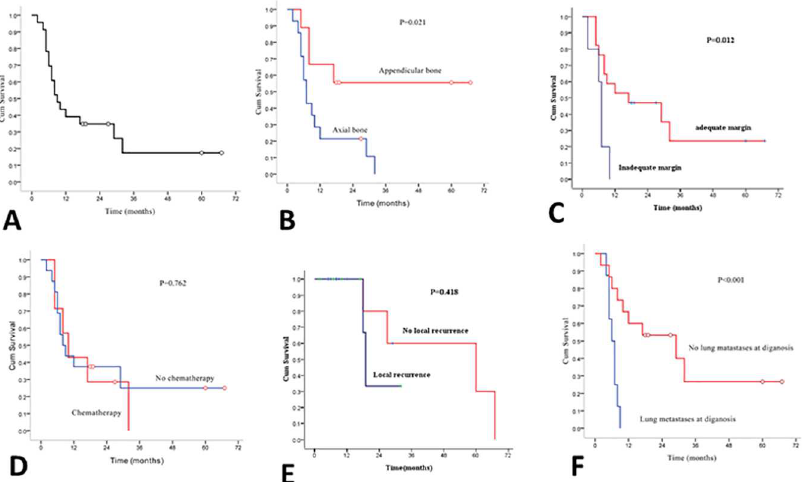
Fig 6. Kaplan-Meier survival curve for 23 cases. (A) The overall mediansurvival time was nine months. (B). Overall survival time for cases in the appendicular bone comparedwith those in the axial skeleton; the difference is significant.(C). Overall survival time for cases with wide or radical surgicalmargin comparedwith inadequate margin; the difference is significant.(D). Overall survival time for cases pre- or post-chemotherapy comparedto those without; the difference is not significant.(E). Overall survival time for cases with local recurrence compared to those without; the difference is not significant.(F). The survival curve for cases with lung metastasis at initial diagnosis comparedto those without; the difference is